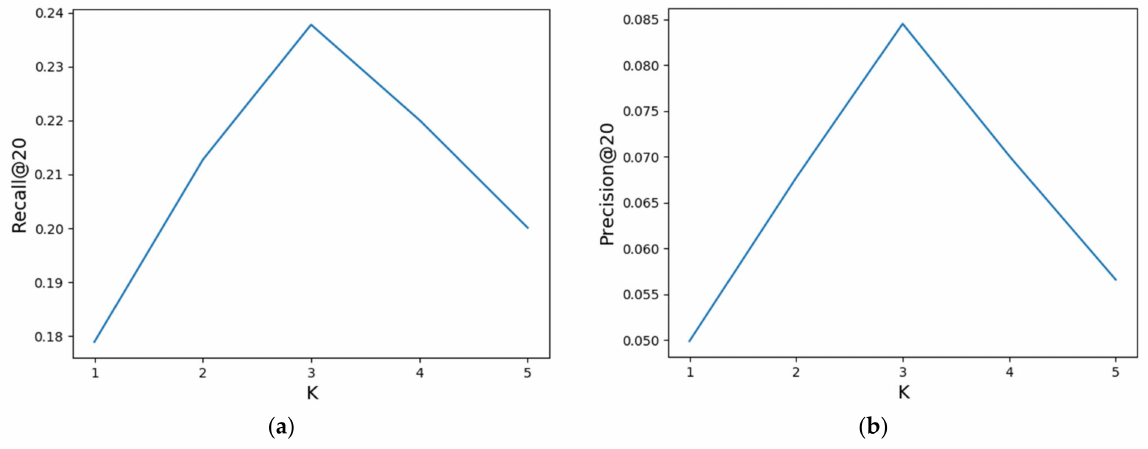
Figure 3. Effects of hyper-parameter K in terms of Recall@20 and Precision@20 in the dataset of MovieLens-1M: ( a ) effects of hyper-parameter K in terms of Recall@20; ( b ) effects of hyper-parameter K in terms of Precision @20.